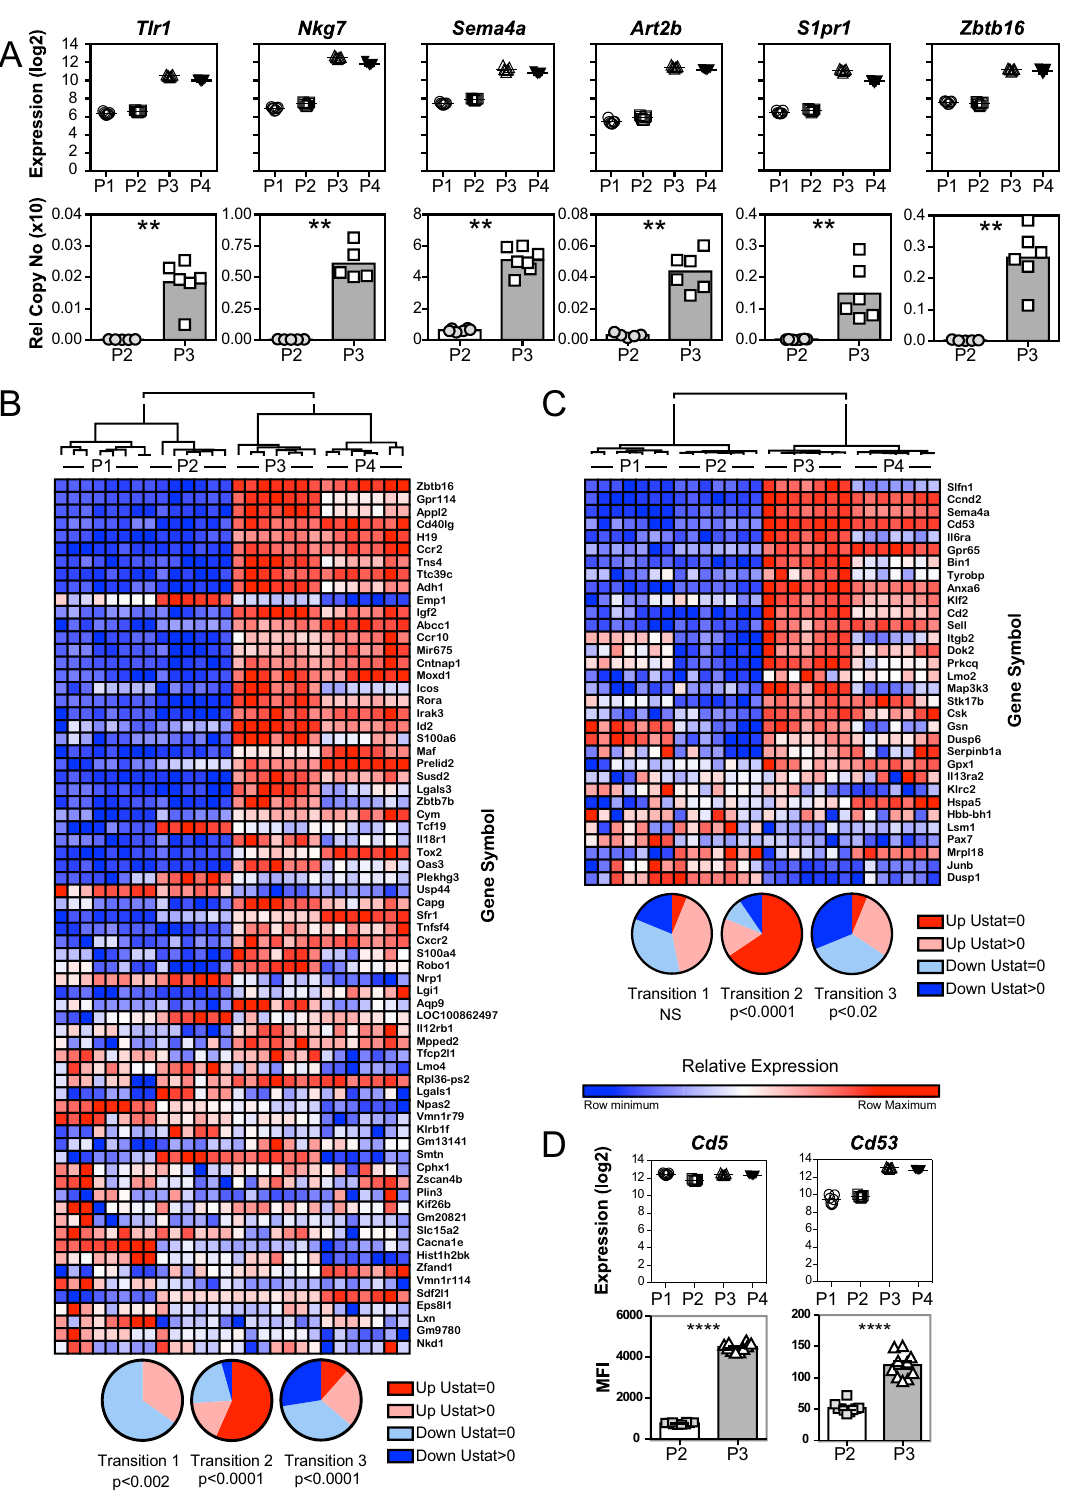
Figure 6. Gene expression profiles. ( A ) Expression profiles of genes related to lineage commitment across Transition 2. Gene expression as determined by microarray (top row; n = 7/grp) and confirmation by qPCR on an independent cohort (bottom row; n = 7/ grp). ( B , C ) Heat maps showing expression profiles of the different cell types across the three transitions for the 69 transcripts, reported by Savage et al. 46 to be modulated by Promyelocytic Leukaemia Zinc Finger (PLZF) ( B ) and the 32 transcripts, reported by Huang et al. 47 to involve in positive selection of conventional T cells ( C ). Pie charts show proportion of transcripts up- and down-regulated across the three transitions (up-regulated and U statistic = 0, up-regulated and U statistic > 0, down-regulated and U statistic = 0, and down-regulated and U statistic > 0) (Heat maps, hierarchical clustering and pie charts depicted in B and C were prepared using Cytoscape 3.8.0 https:// github. com/ cytos cape/)) ( D ) Expression profiles of leukocyte differentiation markers, Cd5 and Cd53 as determined by microarray (top row) and protein levels confirmed by flow cytometry on an independent cohort (bottom row; n = 10 female mice per group; Mann–Whitney U test, ****p <